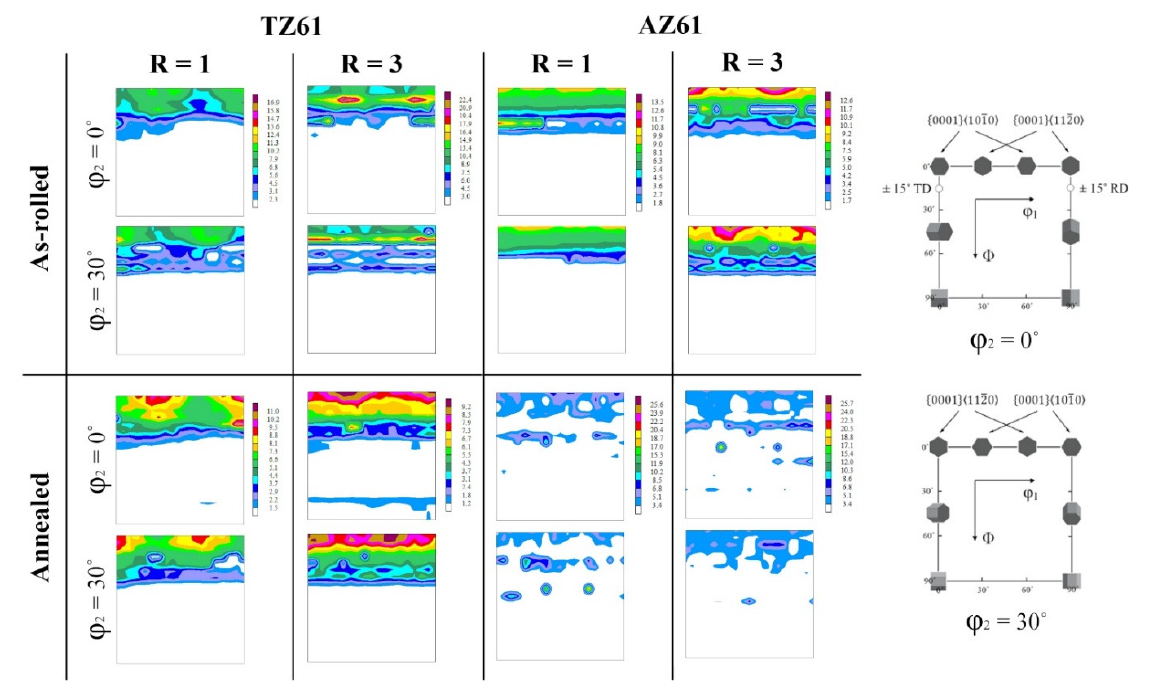
Figure 6. The ODFs ( ϕ 2 = 0° and 30° sections) of as-rolled and annealed TZ61 and AZ61 sheets processed at R = 1 and 3.